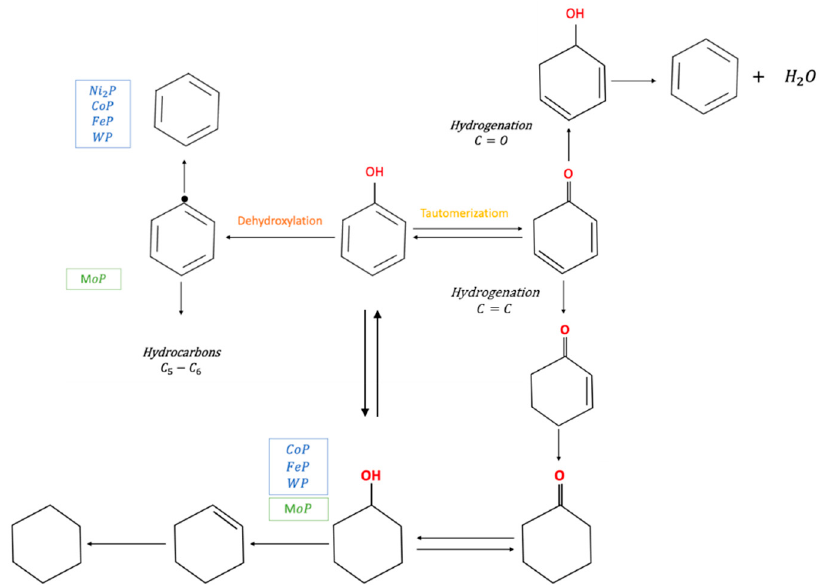
Figure 9. Reaction pathway for HDO of phenol over various supported TMP catalysts. Adapted from Ref. [118].